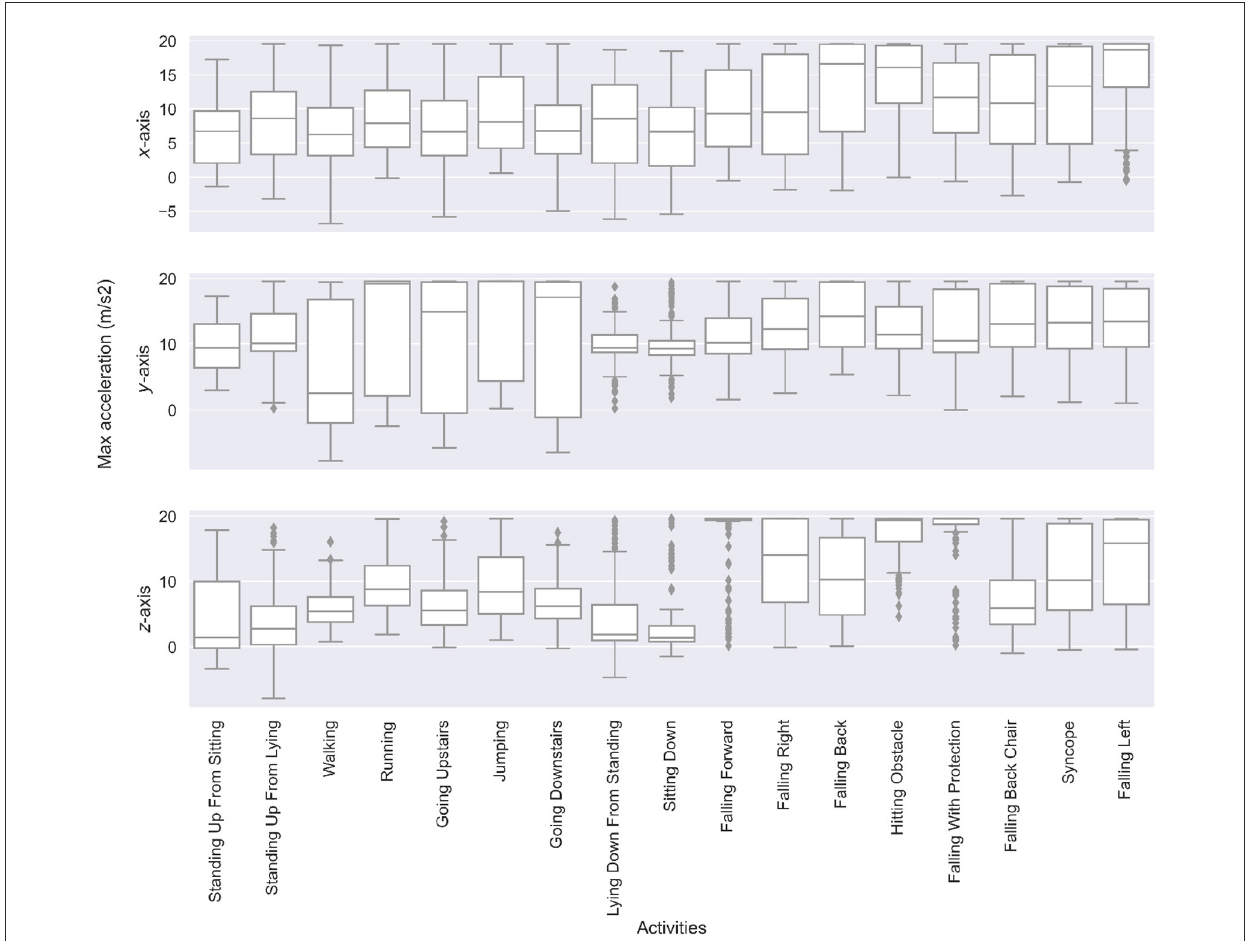
FIGURE5 Boxplots of the maximum acceleration value along the x -, y -, and z -axis for each type of ADL and falls. Falls have significantly higher maximum accelerations than ADLs. Moreover, the direction of the fall is reflected in the differences of x -, y -, and z -axis accelerations.